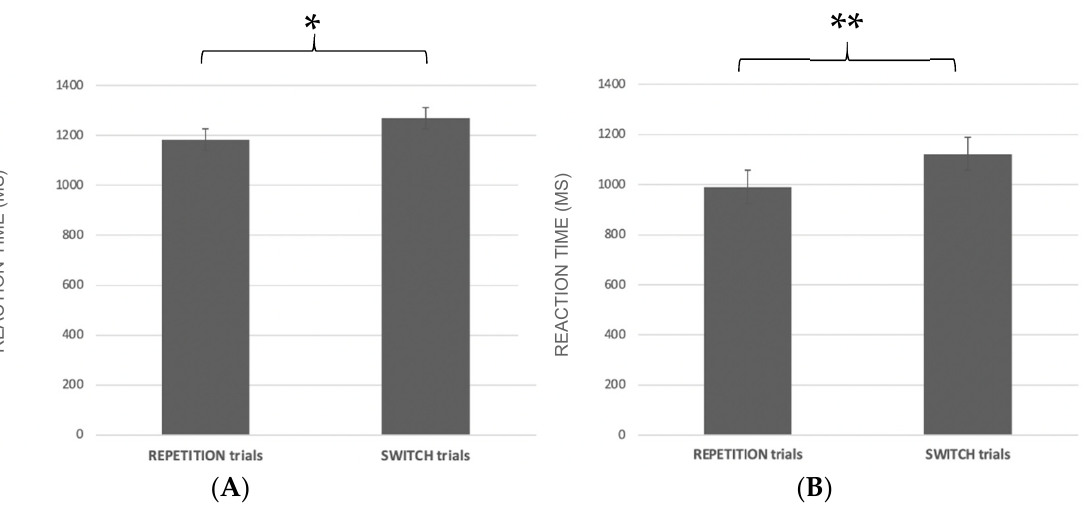
Figure 5. Reaction time (in ms) in the Valence and Color task ( A ); reaction time in the repetition and